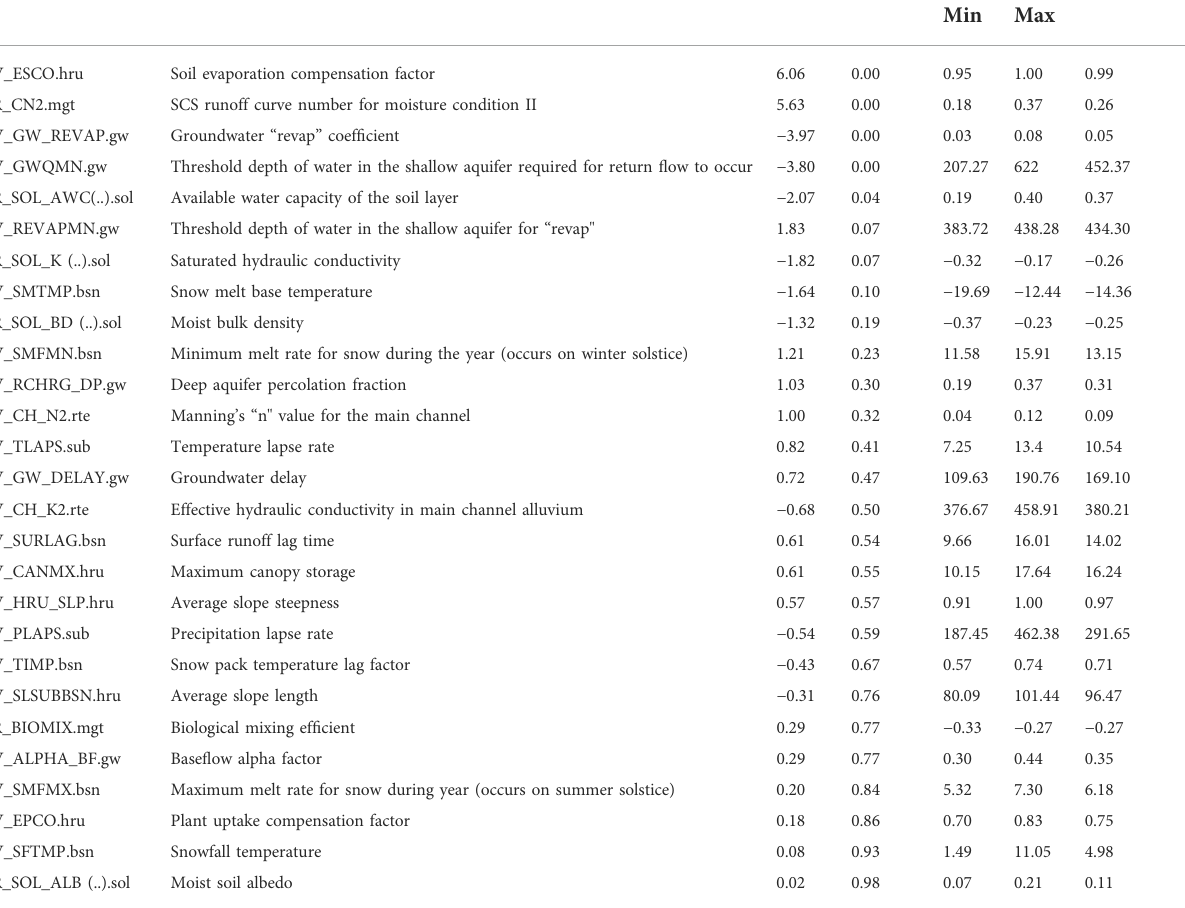
TABLE 3 SWAT model parameter sensitivity and calibration.